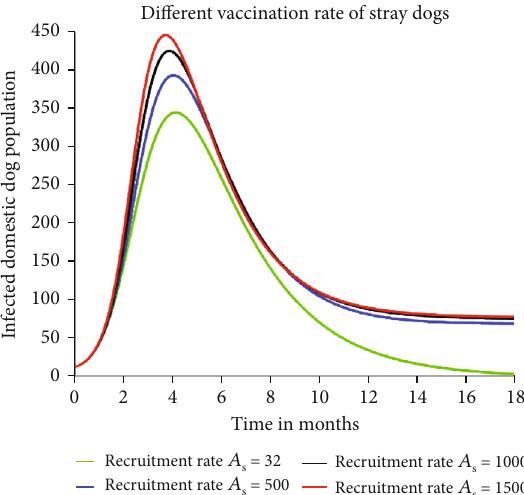
Figure 6: E ff ect of stray dog recruitment rate ( parameter A infected domestic dog population.